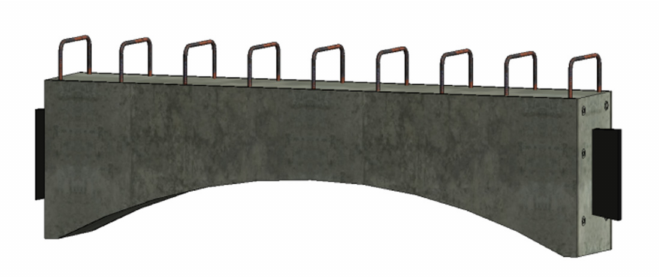
Figure 3. Schematic of the precast coupling beam.